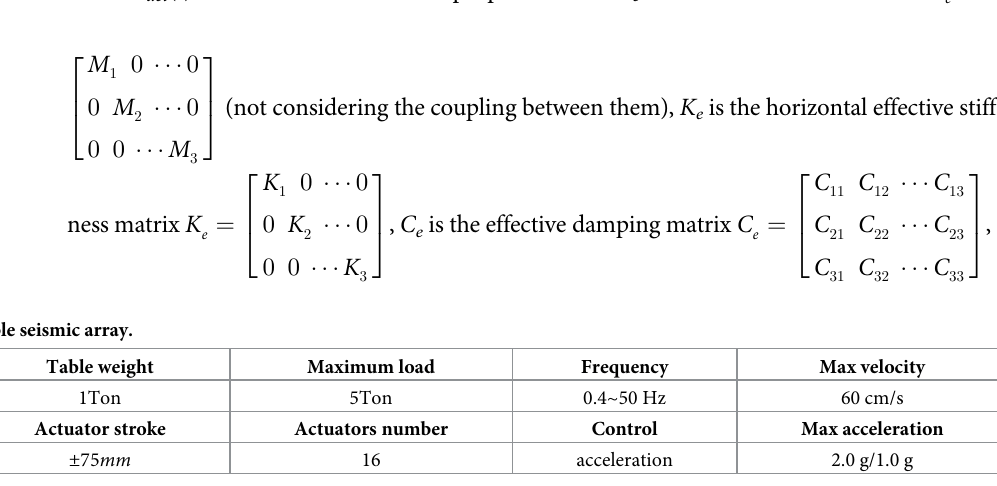
where F ( t ) is the horizontal actuator propulsion and M act